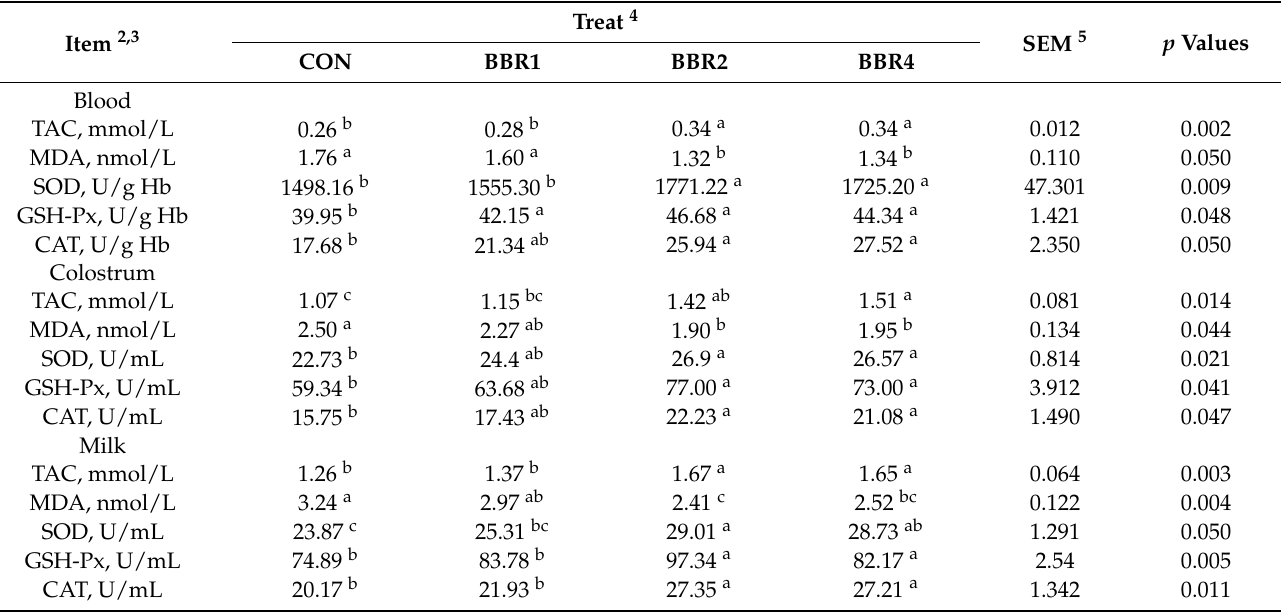
Table 5. Effect of Berberine (BBR) supplementation on antioxidant status of colostrum, milk, and blood in transition dairy Saanen goats 1